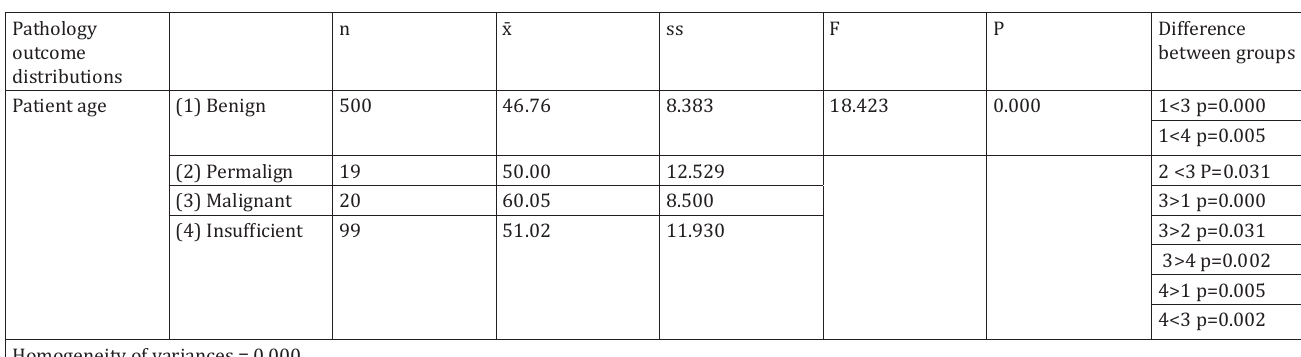
* Row percentage is taken. χ²=13.08 Sd=3 ANOVA results regarding the significance of the difference between age and pathology outcome